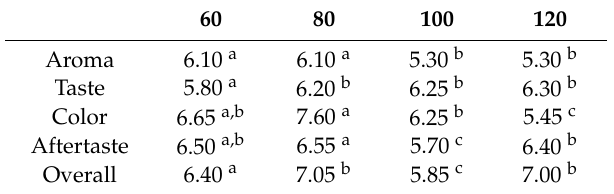
Table 2. E ff ects of drying temperature on the sensory characteristics of the Roselle tea. Table 2. Effects of drying temperature on the sensory characteristics of the Roselle tea.